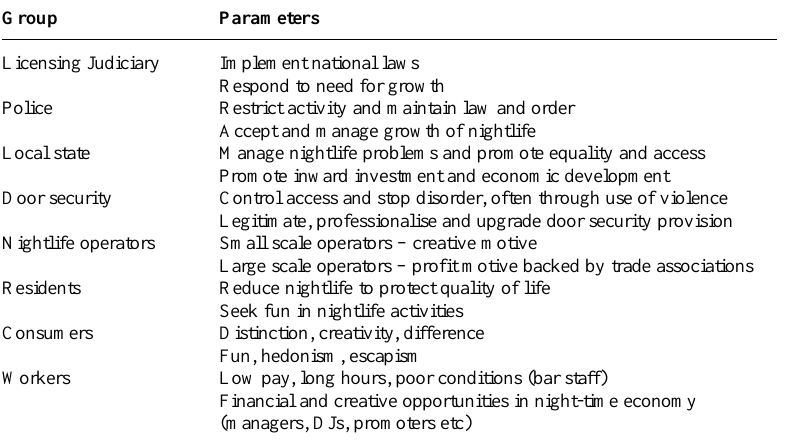
TABLE 1 PARAMETERS AMONGST NIGHTLIFE